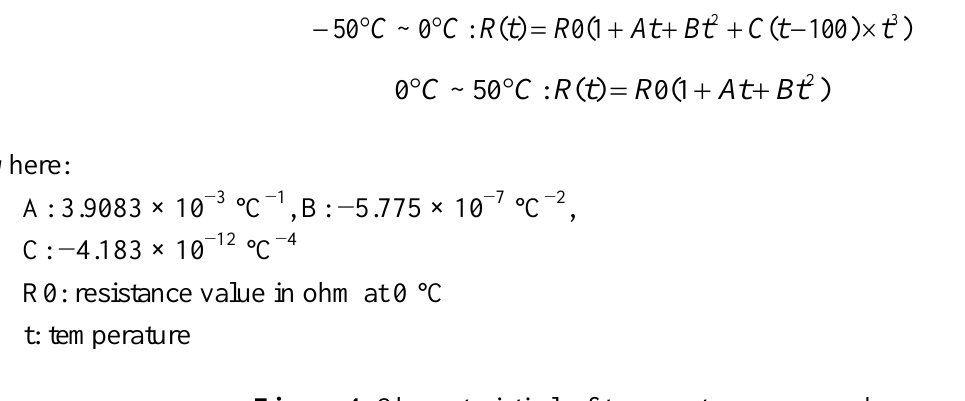
Figure 4. Characteristic leaf temperature curve and